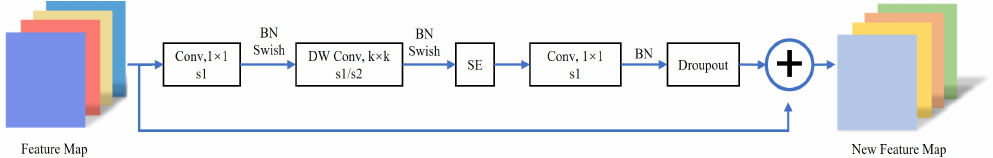
Figure 2. Module structure of MBConv. The Droupout layer performs random inactivation, which causes the activation value of the neurons to stop working with a certain